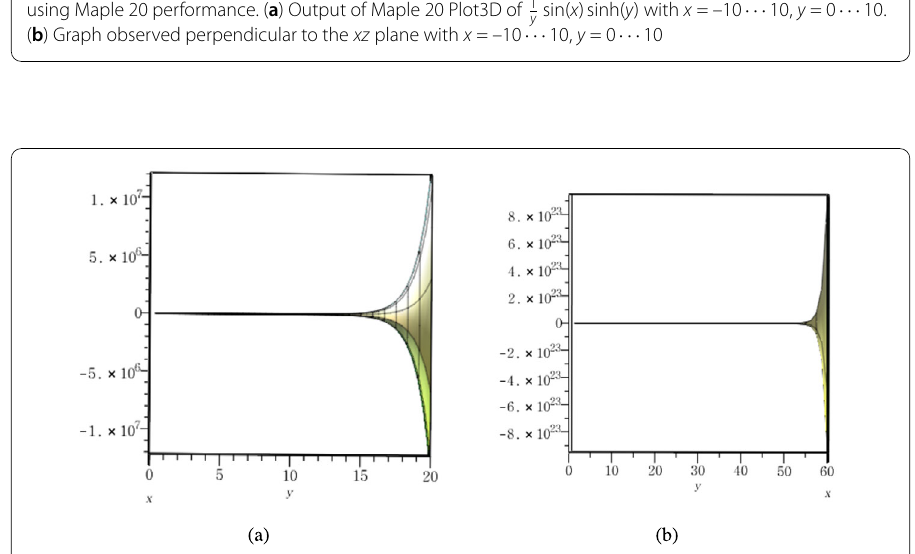
Figure 6 Figures showing the size of the remainder term of D cos( p ) as the size of x = S p and y = | V p | changes using Maple 20 performance. ( a ) Output of Maple 20 Plot3D of